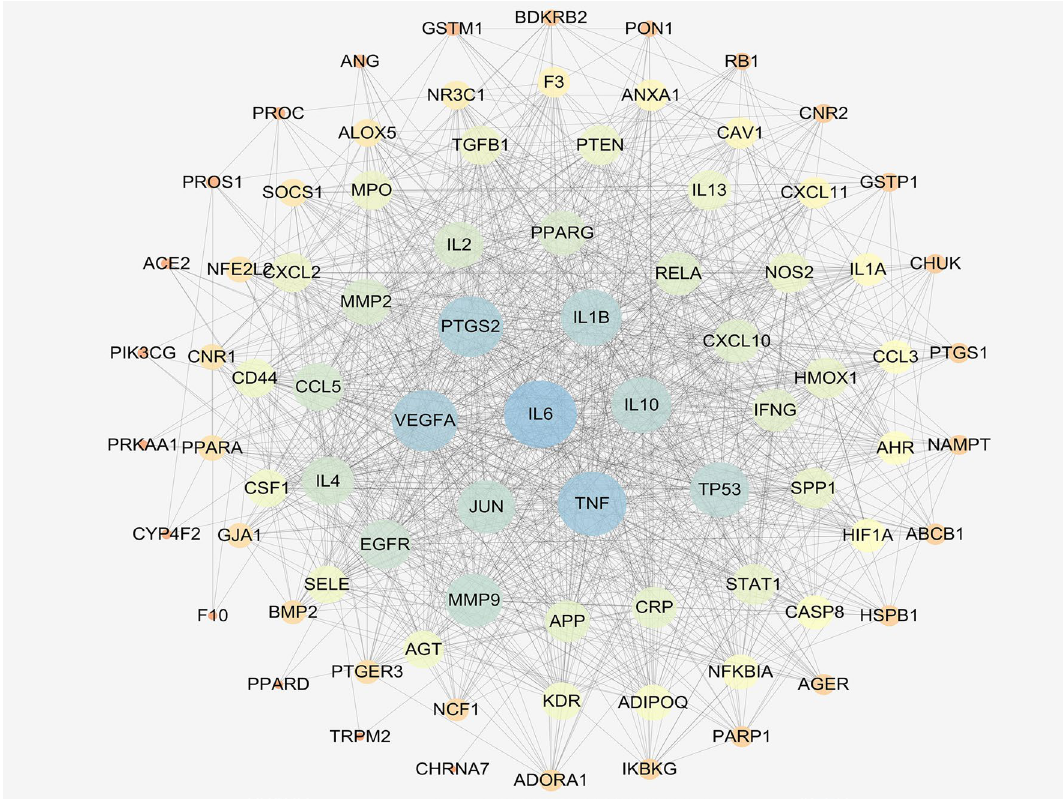
Figure 3. Protein–protein interaction (PPI) network analysis of Kushen for the treatment of inflammation using STRING database.